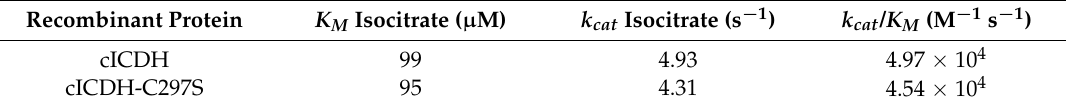
Table 1. Steady-state enzymatic parameters for cICDH and cICDH-C297S. Recombinant